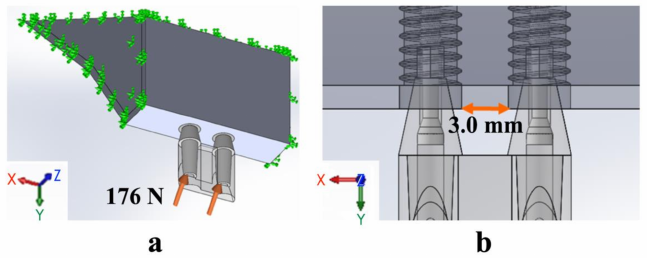
Figure 2. Implant and surrounding maxillary bone used for finite element analysis and modeling. ( a ) Overview of the conical connection (CC) model. ( b ) View of the CC model from the labial side. Two implants are implanted so that the inter-implant distance is 3.0